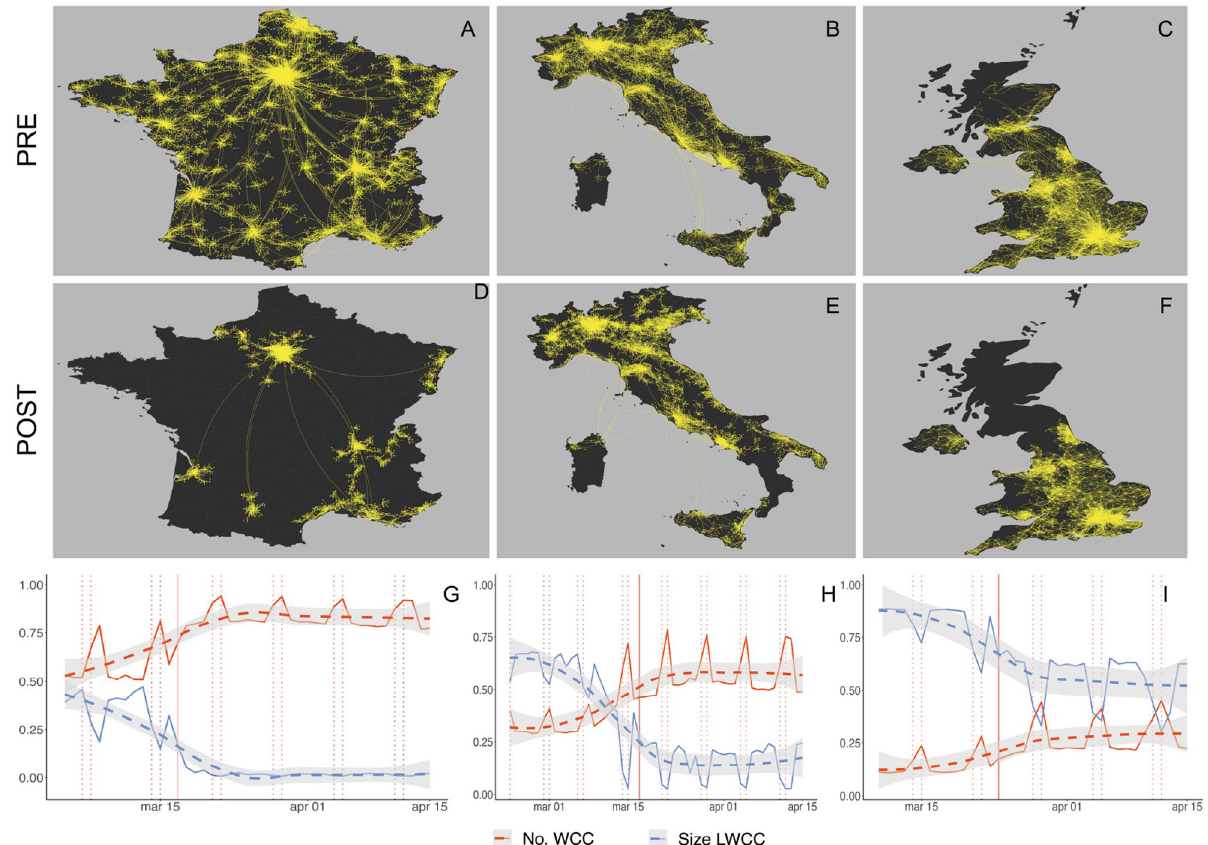
Figure 1. Outlook on national mobility networks for France, Italy and UK during COVID-19 pandemic. Panels ( A – F ) show the largest weakly connected components (LWCC) of national mobility networks built on two disjoint symmetric windows: respectively 2 weeks before (panels A – C ) and 2 weeks after ( D – F ) the day of national lockdown. The lockdown dates are respectively March 17th for France, March 9th for Italy and March 24th for UK. Bright dots represent municipalities that belong to the LWCC. We observe the following reductions in terms of nodes that disappear from the main cluster. France: from 5495 to 1174 nodes. Italy: from 2733 to 2293 nodes. UK: from 1072 to 844 nodes. Panels ( G – I ) show the temporal evolution of daily connectivity for national mobility networks of municipalities, in terms of number of weakly connected components (No. WCC) and size of the largest weakly connected component (LWCC). Both quantities are normalized using the number of nodes of the corresponding network. We visualize trends by means of a LOESS regression (dashed lines with 95% confidence intervals shaded in grey) and highlight lockdown and week-end days with vertical red lines, respectively solid and dashed